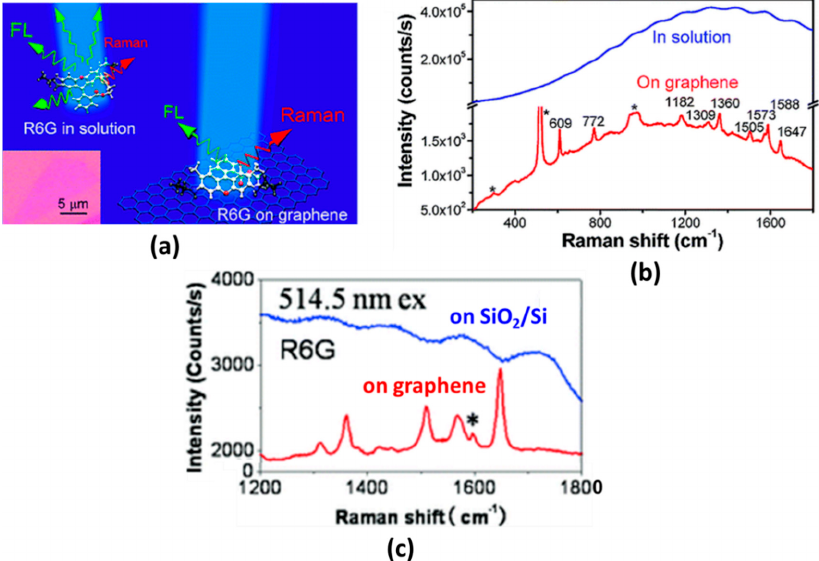
Figure 28. ( a ) Schematic illustration of graphene as a substrate for suppressing the photoluminescence of R6G. ( b ) Raman spectrum of R6G in water (blue line) and R6G in single layer graphene (red line). ( c ) Raman spectra of R6G on SiO 2 /Si and graphene substrate, respectively (adapted with permission from Reference [109,110], copyright American Chemical Society).